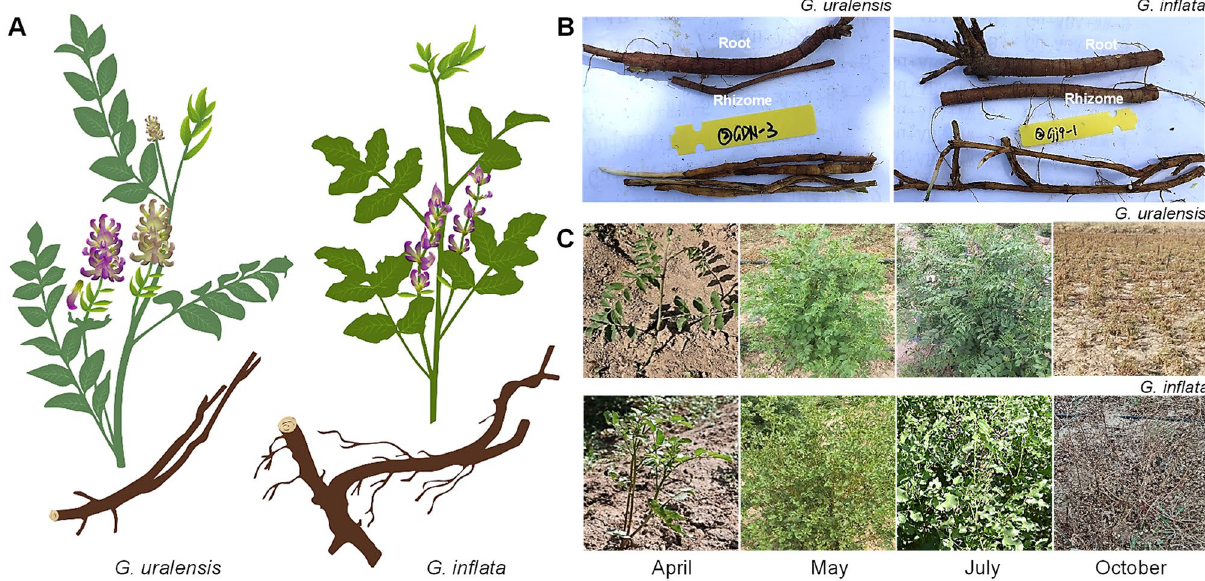
Figure 1. The morphology of different tissues under different developmental stages of G. uralensis and G. inflata . (A) schematic drawings of G. uralensis and G. inflate, respectively; (B) morphology of root and rhizome of G. urelensis and G. inflata, respectively; (C) G. urelensis and G. inflate, respectively, in different developmental stages, including Returning green stage (April), Rapid growth and flowering stage (May), Seed setting (July), and Senescence stage